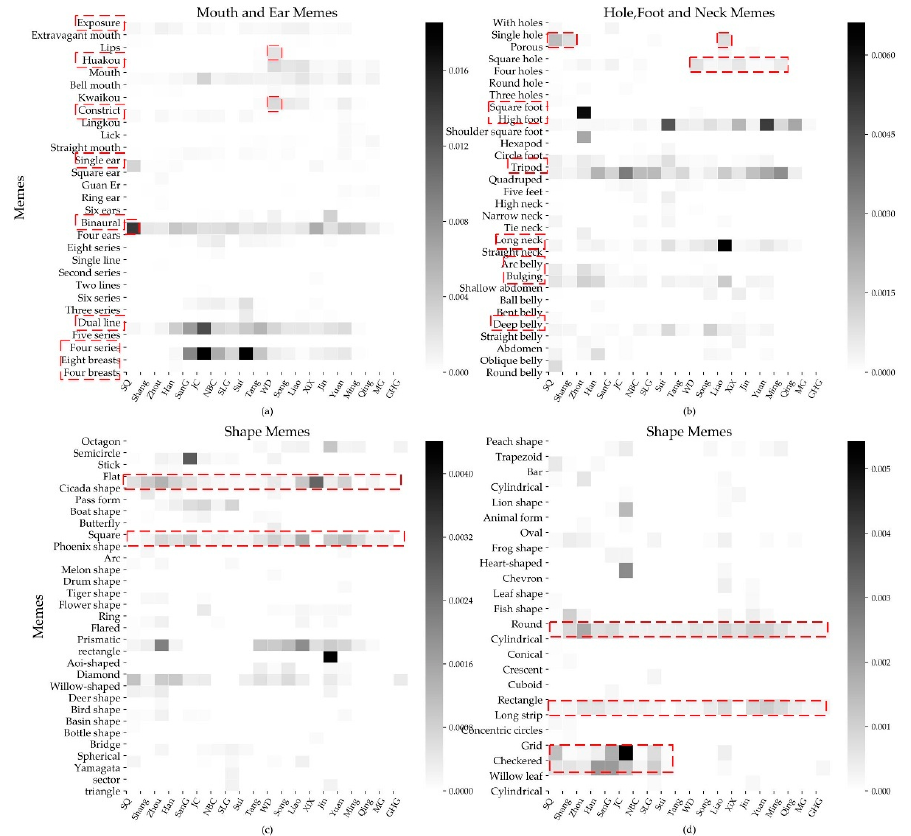
Figure 5. Distribution trend of shape memes. ( a ) Shows the distribution of mouth shape and ear shape. ( b ) Shows the distribution of hole shape, foot shape, and neck shape. ( c , d ) are the overall shape description of cultural relics.